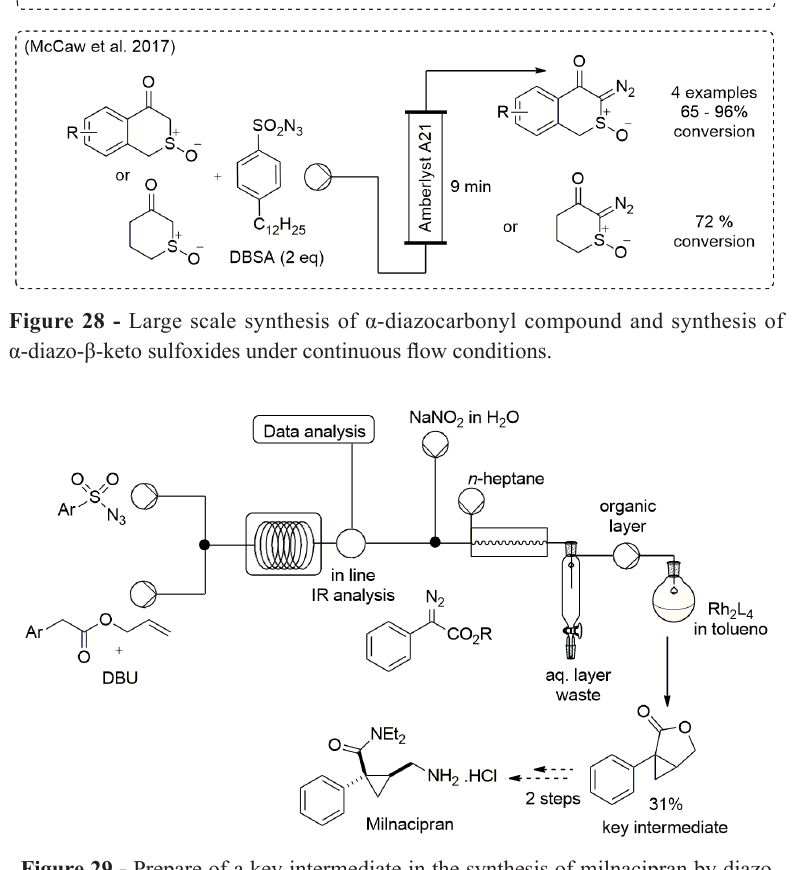
Figure 29 - Prepare of a key intermediate in the synthesis of milnacipran by diazo transfer reaction in continuous